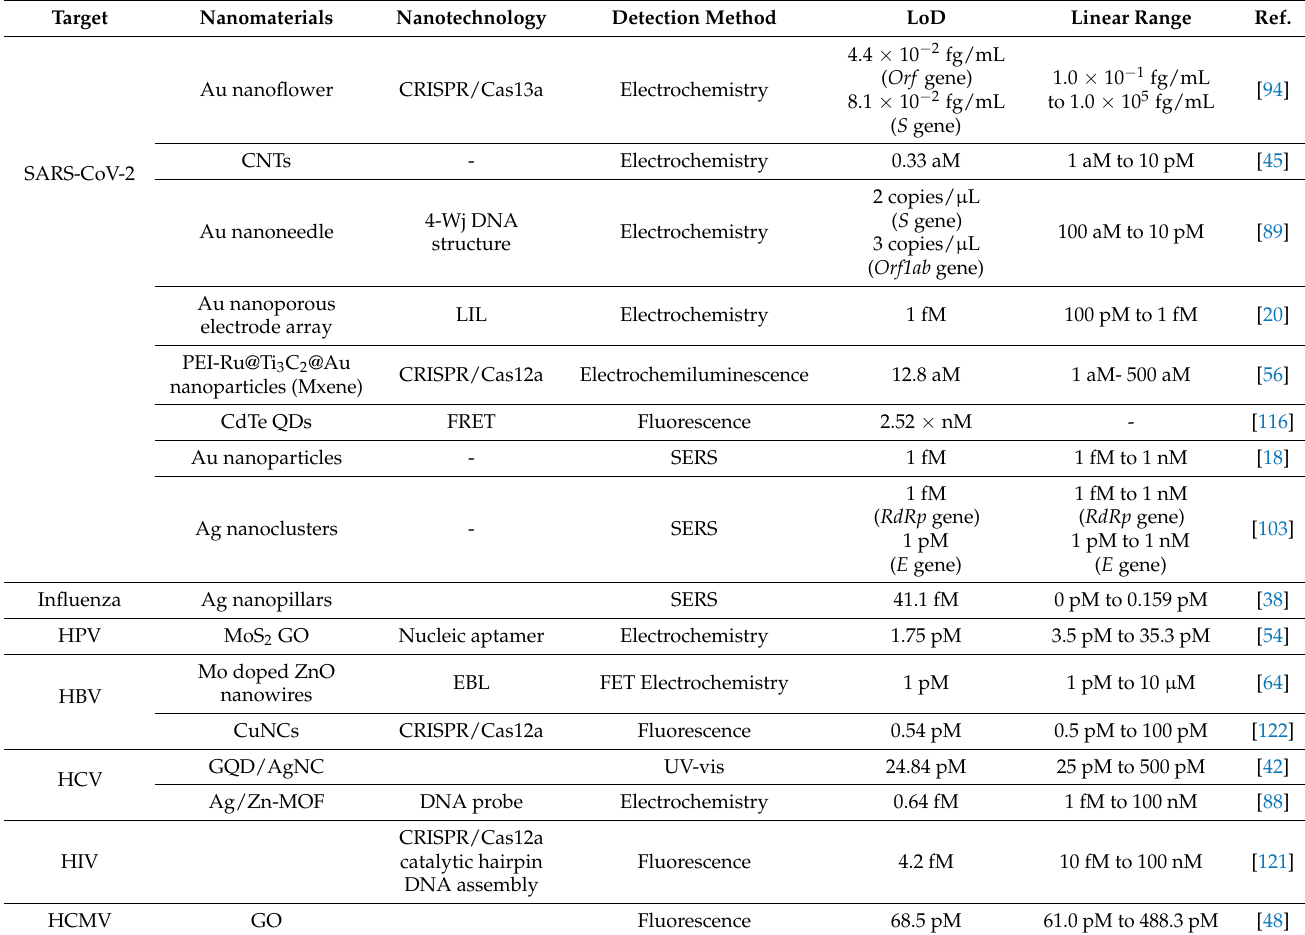
Table 1. The representative viral nucleic acids biosensors illustrated in this